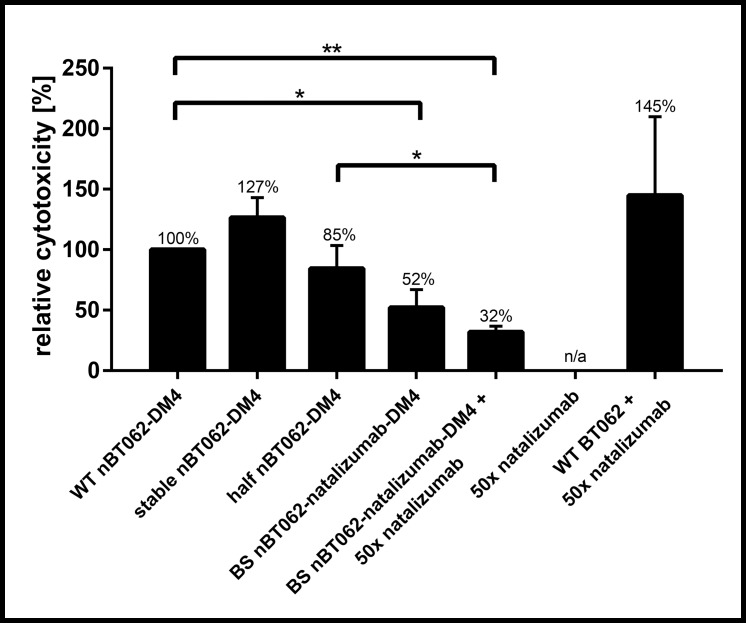
nBT062-DM4 model variants kill CD138+ NCI-H929 tumor cells in vitro.NCI-H929 cells (CD138+/CD49d+) were incubated for 5 days with varying concentrations of WT nBT062-DM4, stable nBT062-DM4, half nBT062-DM4 and bispecific nBT062-natalizumab-DM4 antibodies. Natalizumab was used for CD49d blocking. Reciprocal IC50 values of each antibody-drug conjugate were normalized to WT nBT062-DM4 and one DM4 molecule per antibody. Results are shown from three separate experiments each measured in triplicates. *p<0.05, **p<0.01.